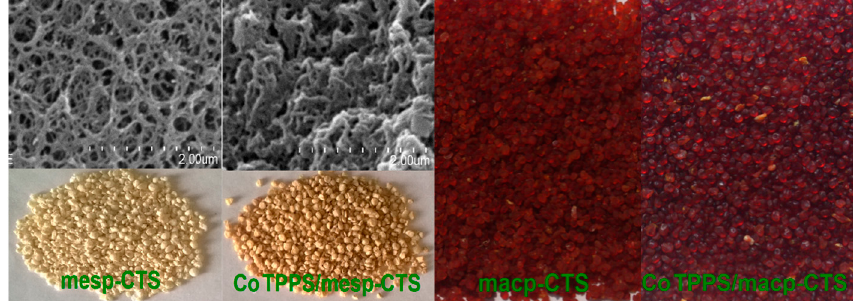
Figure 1. Images of mesoporous chitosan (mesp-CTS), cobalt tetrakis(p-sulphophenyl)porphyrin chloride(Co TPPS)/mesp-CTS, macroporous-CTS (macp-CTS) and Co TPPS/macp-CTS; scanning